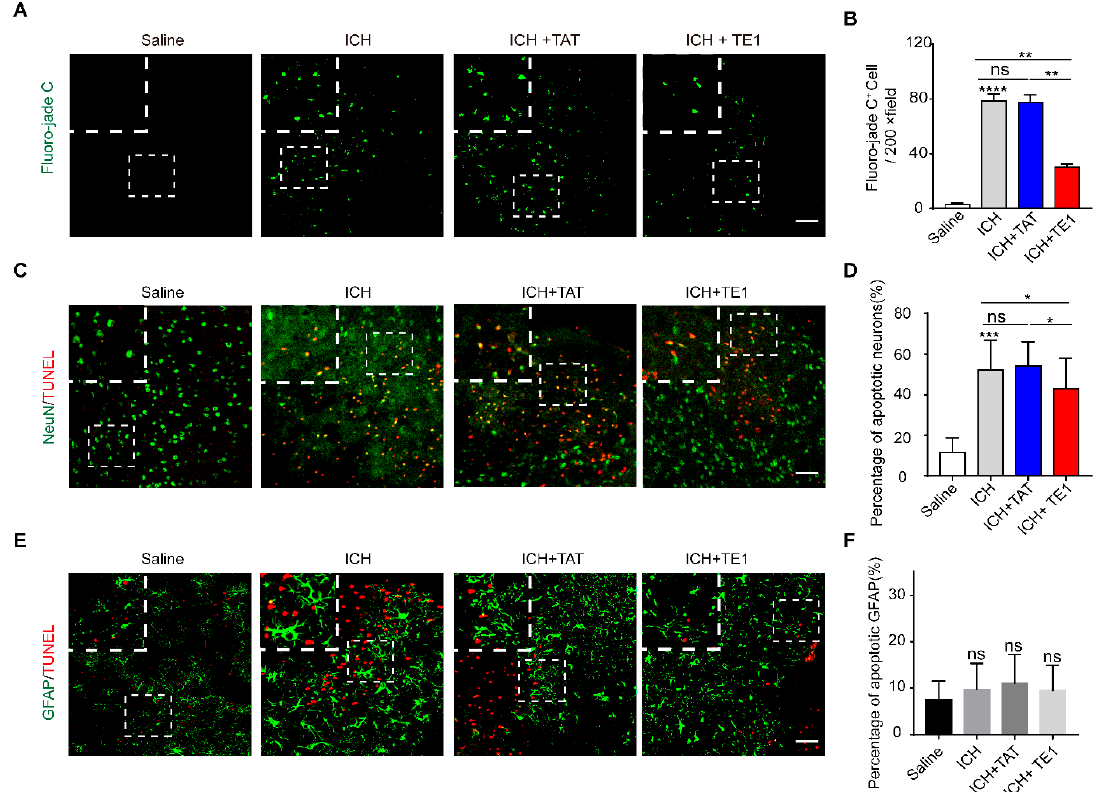
Figure 6. Netrin-1 derived peptide E1 can protect against neuronal death and degeneration, but not astrocytes after ICH. ( A ) Representative Fluoro-jade C-stained sections in mice treat with/without TE1 at 5 days after ICH. Scale bar, 50 µ m and 10 µ m, respectively. ( B ) Quantitation of Fluoro-jade C positive cells in the perihematomal region ( n = 4). ( C ) TUNEL staining showing effects of TE1 on secondary brain injury (SBI) at 5 days after ICH onsets. Representative images from Saline, ICH, ICH + TAT, ICH + TE1 groups. Each group was subjected to ICH except for the Saline group. Scale bar, 50 µ m and 10 µ m respectively. ( D ) Quantitative analyses for the percentage of TUNEL-positive neurons shown in ( C ). n = 4. ( E ) Colocalization of TUNEL with GFAP at 5 days after ICH. Representative images from Saline, ICH, ICH + TAT, ICH + TE1 groups. Scale bar, 50 µ m and 10 µ m, respectively. ( F ) Quantitative analyses for the percentage of TUNEL-positive astrocytes shown in ( E ). n = 4. Data are presented as the means ± SEM. One-way ANOVA was used for all statistical analyses shown in this figure (* p < 0.05, ** p < 0.01, *** p < 0.001, **** p < 0.0001; ns, not significant). Details of data analysis are seen in Supplementary Table